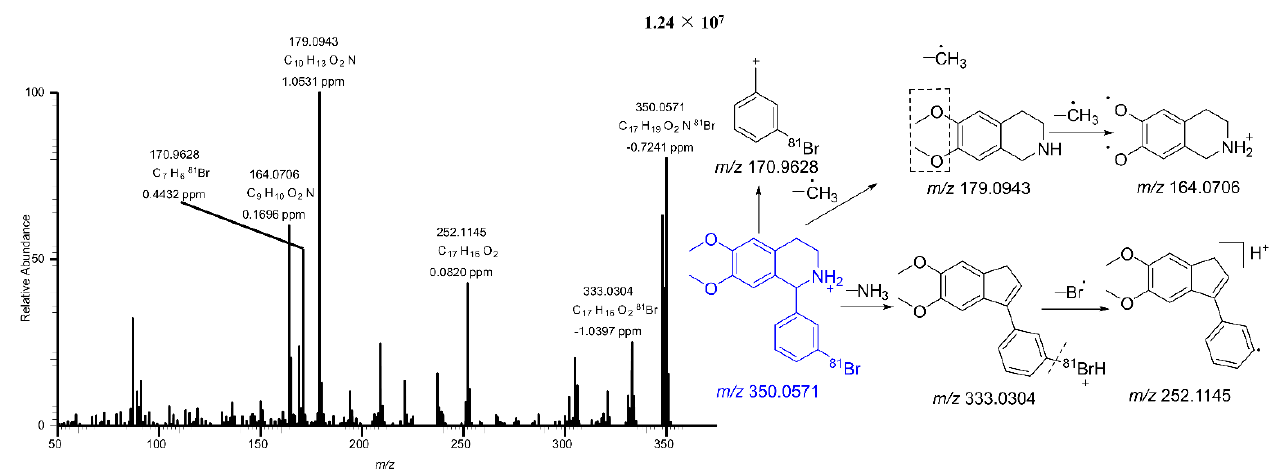
Figure 4. The MS/MS spectra of 1 − ( 3′− bromophenyl) − heliamine.